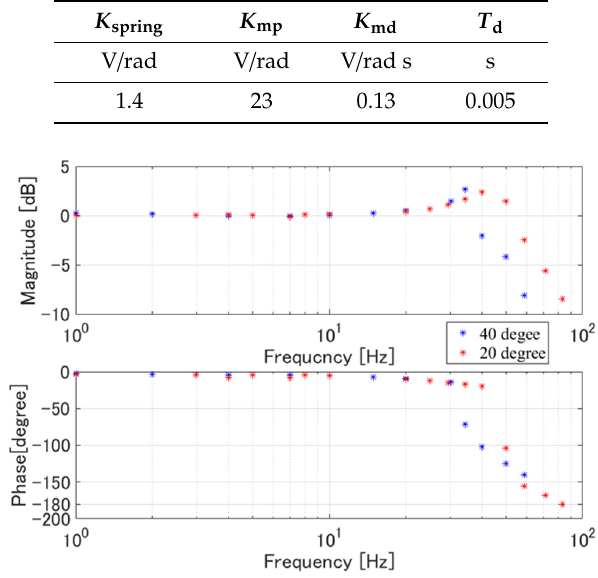
Figure 13. Block diagram of cam angle control.